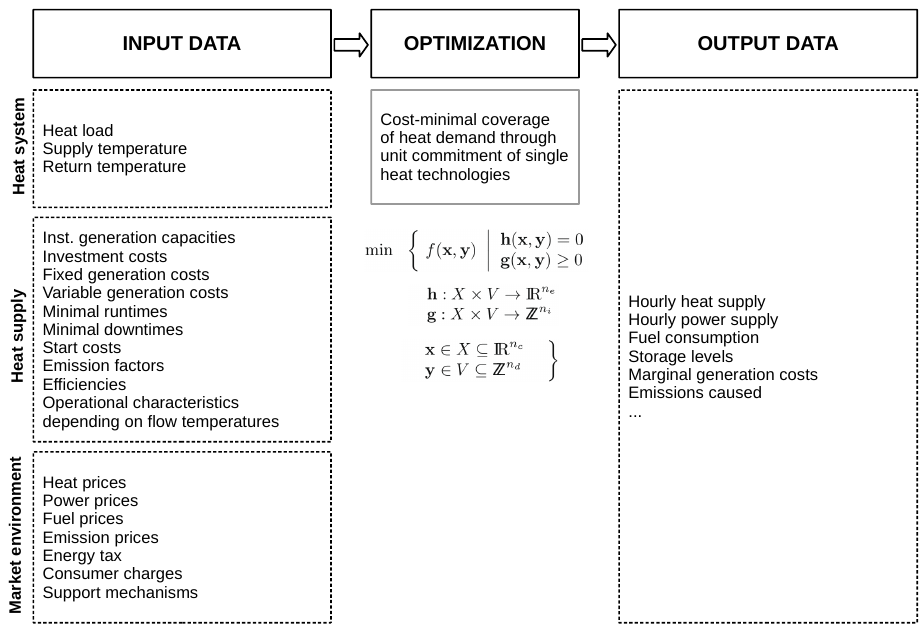
Figure 1. Model description with input and output